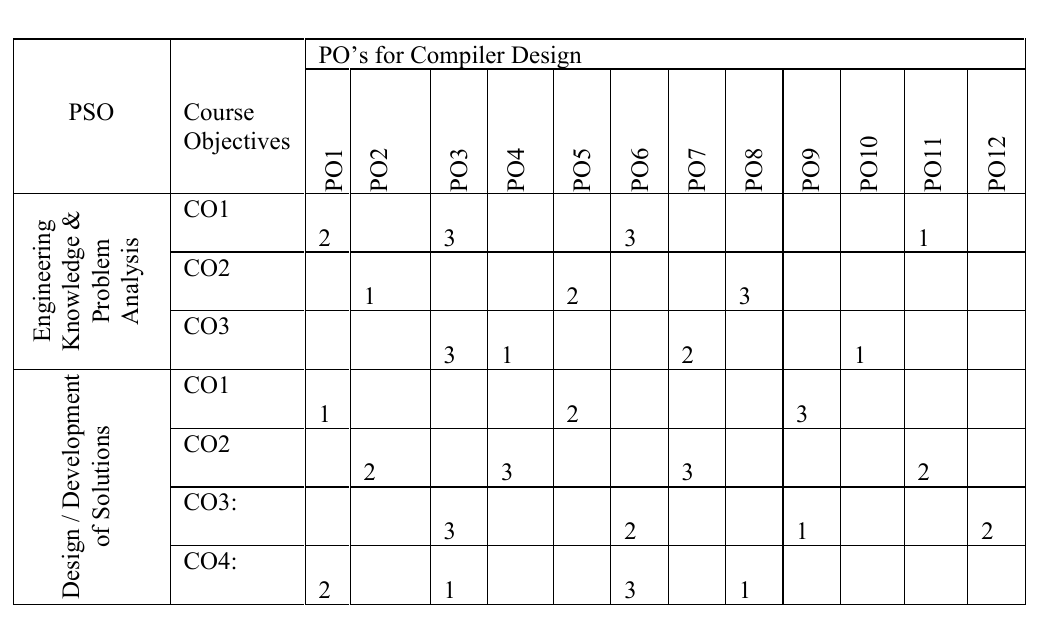
Table 4. Input excel file for CO-PO mapping